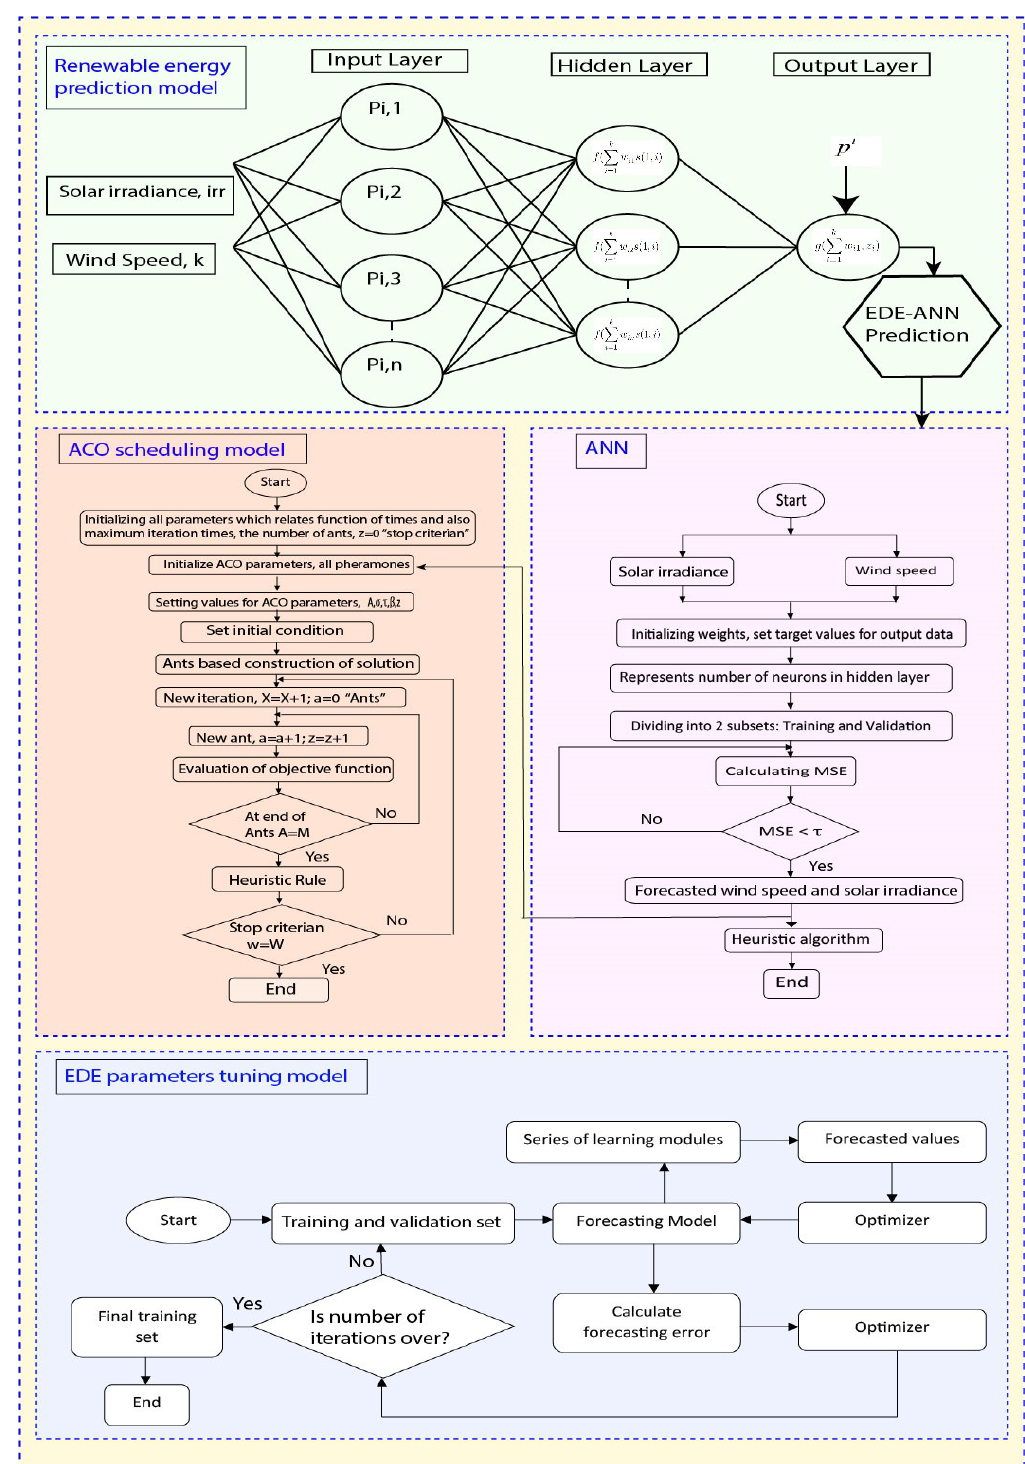
Figure 2. Developed optimal DSM framework working flow